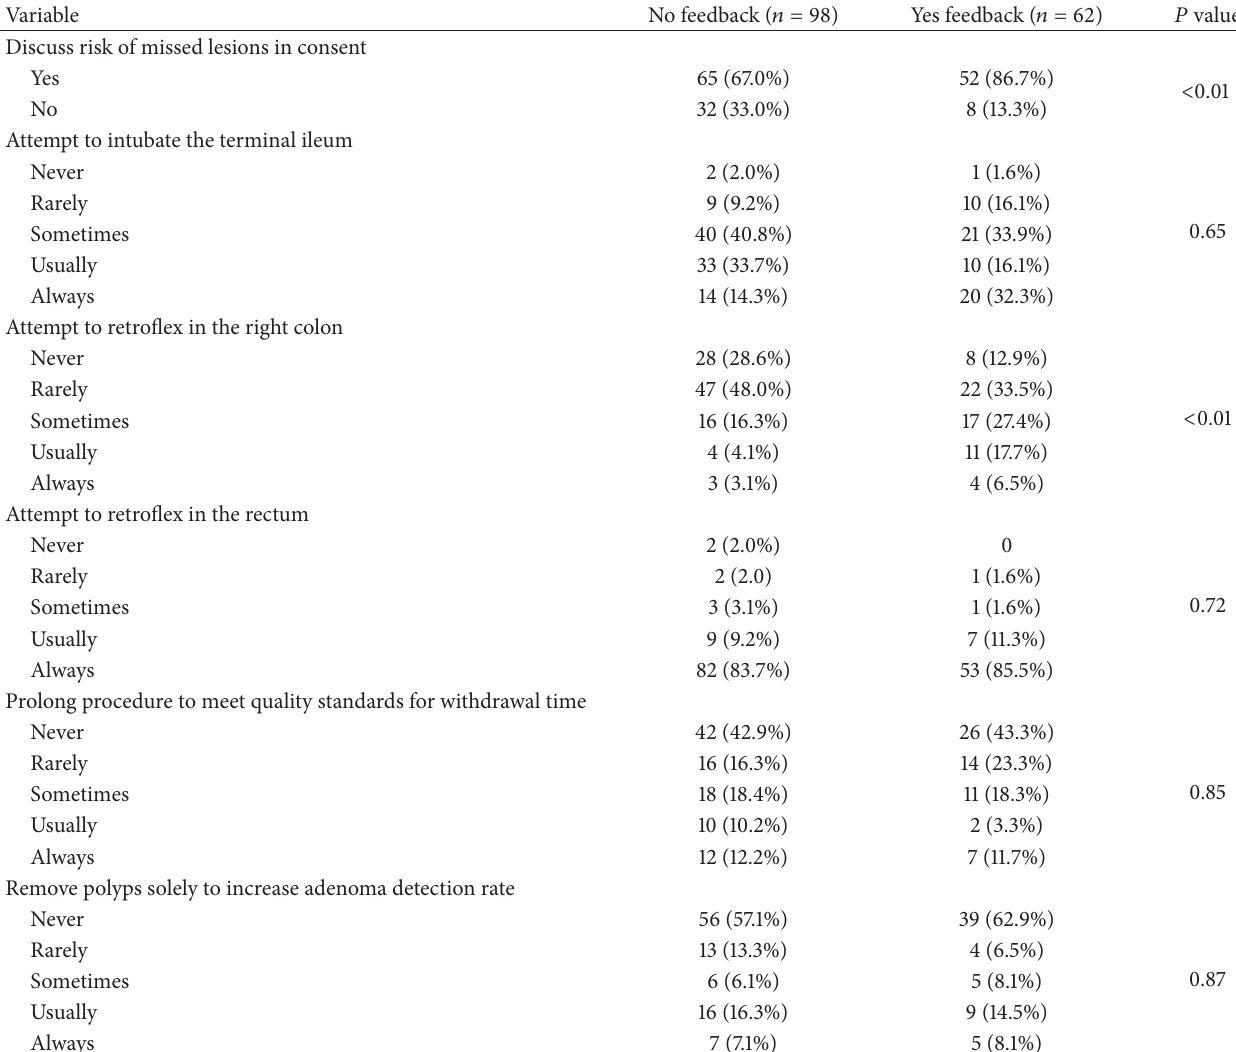
Table 3: Impact of quality feedback on colonoscopy practice in multivariable